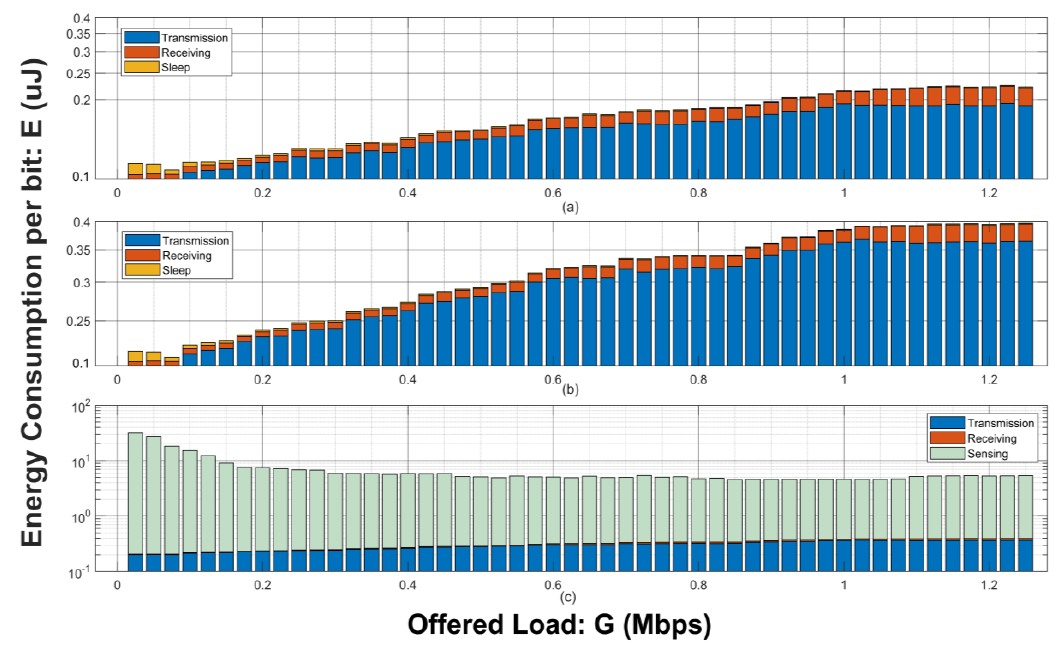
Figure 3. The comparison of required transmission energy per bit virtual sensing directional hub, medium access control protocol (VSDH-MAC) protocol with power control ( a ) and without power control ( b ), and carrier sense multiple access with collision avoidance (CSMA/CA)/distributed coordination function (DCF) protocol ( c ).